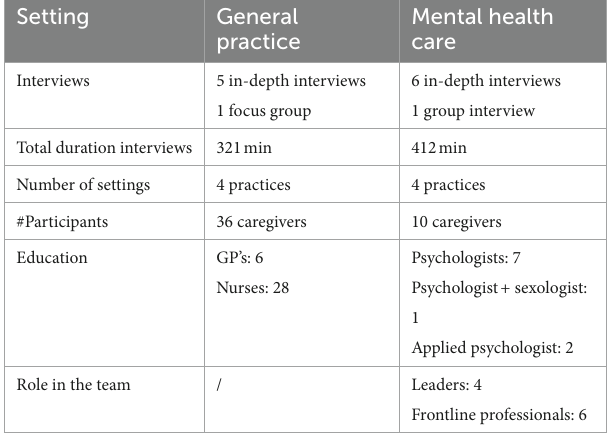
TABLE 2 Overview of research characteristics in stage 1.